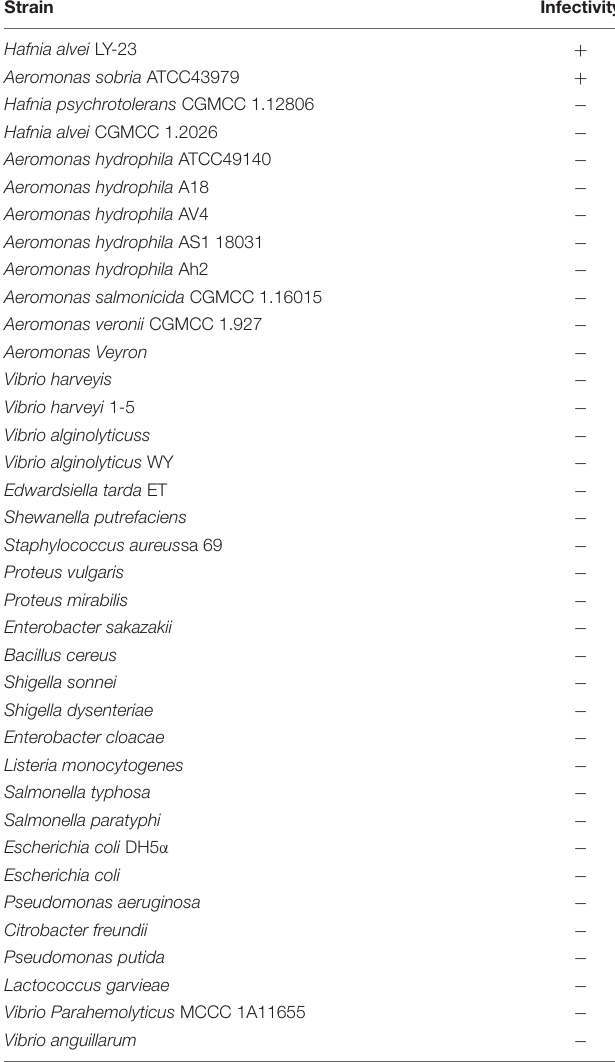
TABLE 1 | The results of the host range analysis test of Hafnia phage Ca.